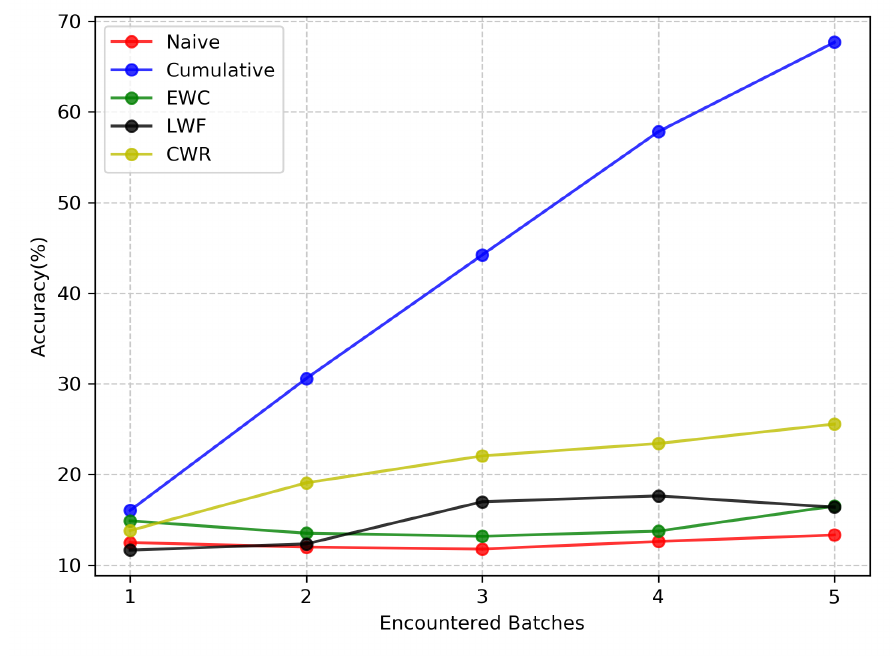
Figure 11. Test accuracy of the five methods on the New Classes (NC) scenario. The final result of each method is the average of scrambling the training batches order five times. CWR = CopyWeights with